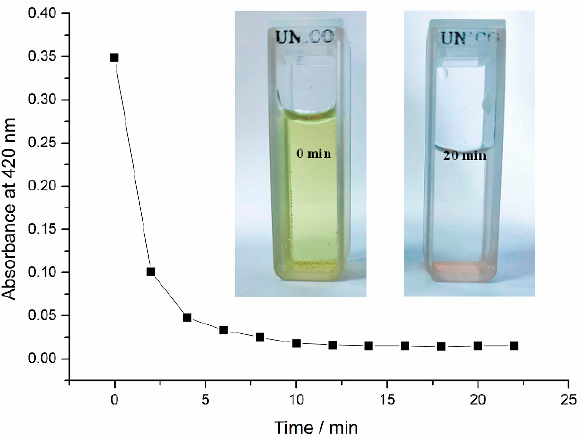
Figure 6. Absorbance at 420 nm of macrocycle 1 (10 μ M) as a function of time following the addition of SDT (1.0 mM), PBS buffer, pH 7.4, 37 °C. Table 3. Kinetics of the reduction in macrocycles 1 , 2 and 4 in the presence of SDT. Macrocycle